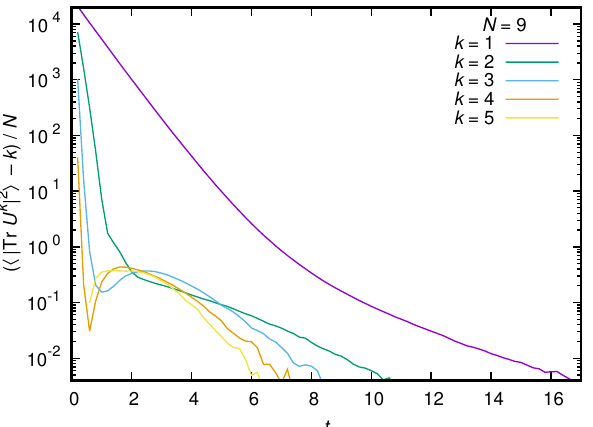
Figure 17 . Plot of ( hj Tr U k j 2 i (cid:0) k ) =N for k = 1 ; 2 ; 3 ; 4 ; 5 against t for the 2-local RCQ chain with dt = 0 : 2. N = 9, 10 5 samples. These exhibit exponential decays with rates that do not decrease as k